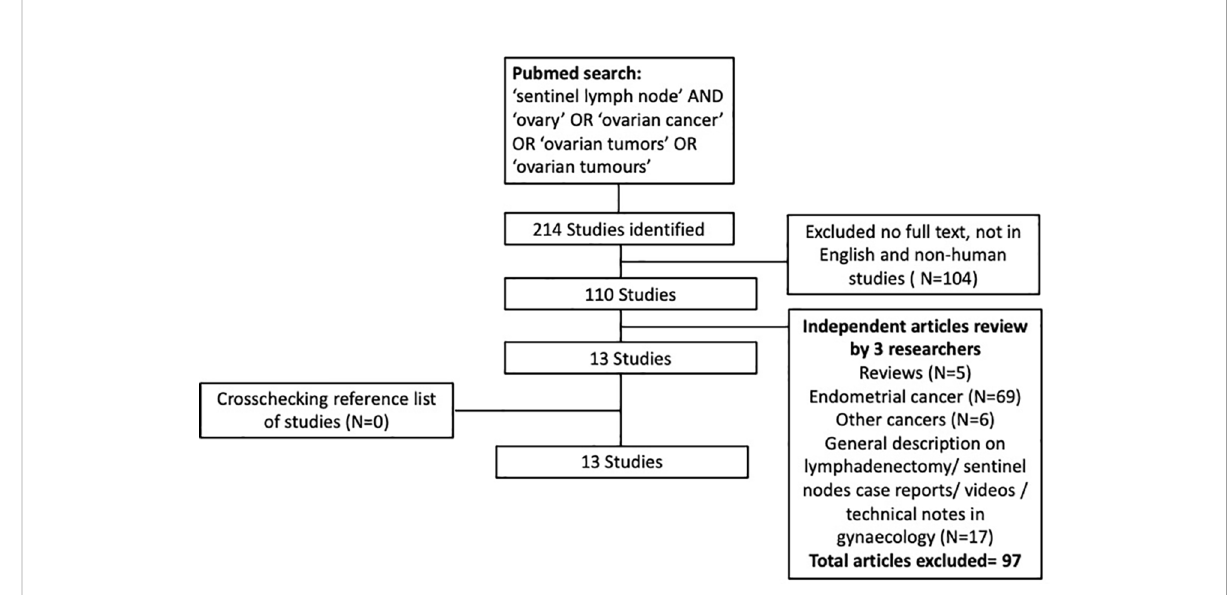
FIGURE 1 Flowchart of study